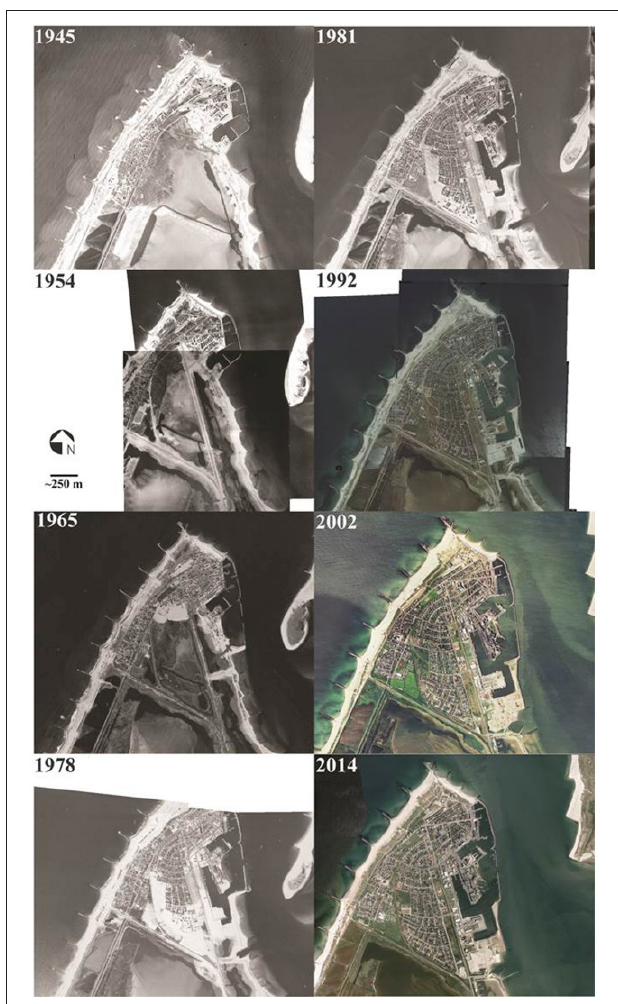
FIGURE 2 | Aerial photography of Thyboron covering the period 1945–2014. Sources: arealinformation.miljoeportal.dk (I-GIS 1945; DDO ® , © COWI 1954, 2002, 2014), flyfotoarkivet.dk (© Geomidt/Lemvig Municipality 1965, 1978, 1981,